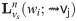
Visualization of the proposed algorithm.Search for alternative paths to edge (1, 6) (dotted arrow), i.e., v
s = 1 and v
t = 6. Solutions Lvsn(wi;⇝vj) to subproblems are managed in a two dimensional solution array indexed by path weight w
i and vertex number v
j. Solutions are calculated iteratively over w
i (rows) and v
j (columns). (A) Solution matrix after first iterative step (subproblem Lvs1(1;⇝v2)): There are two edges leading to vertex 2 of which only edge (1, 2) yields a valid solution by pointing to an earlier solved subproblem (green box), whereas edge (5, 2) has a weight of 7 leading to a negative difference in weights i − w
(5,2) (red box) for which no earlier solution exists; (B) Solution matrix after third iterative step Lvs3(1;⇝v3): Here, no valid solution exists (none of the arrows leading to vertex 2 are part of a path with summed weight 1); (C) Solution array after iteration over all vertices v
j for w
i = 1 (all vertices have been checked for a path of weight 1, originating from the start vertex 1); (D) Solution to subproblem Lvsn(6;⇝v6): edge (4, 6) together with the solution Lvs(5;⇝v4) form a valid path, whereas edge (5, 6) is not part of a valid solution as Lvs(3;⇝v5) is empty; (E) The algorithm terminates after iteration over all vertices v
j and path weights up to w
(vs, vt) + θ, where θ is a user defined threshold of 1. Backtracking is conducted for all entries in the reconstruction interval w
(vs, vt) ± θ (entries marked blue); (F) Reconstructed alternative path by backtracking of subproblems.